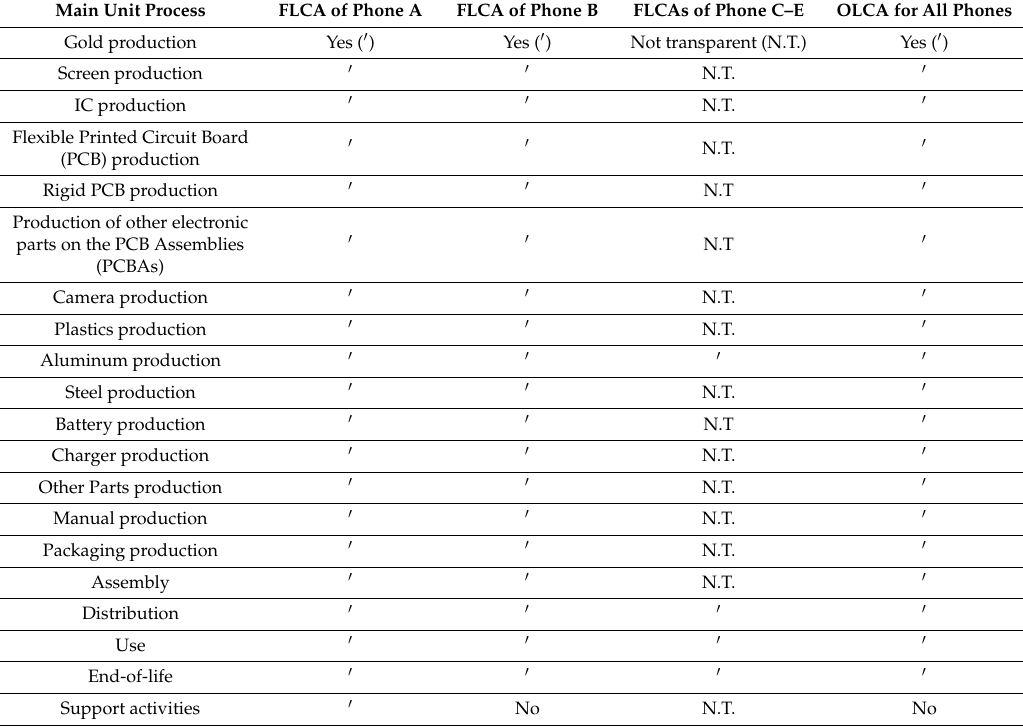
Table 2. Comparison of studied product system for Phone A, B and the OLCA model of